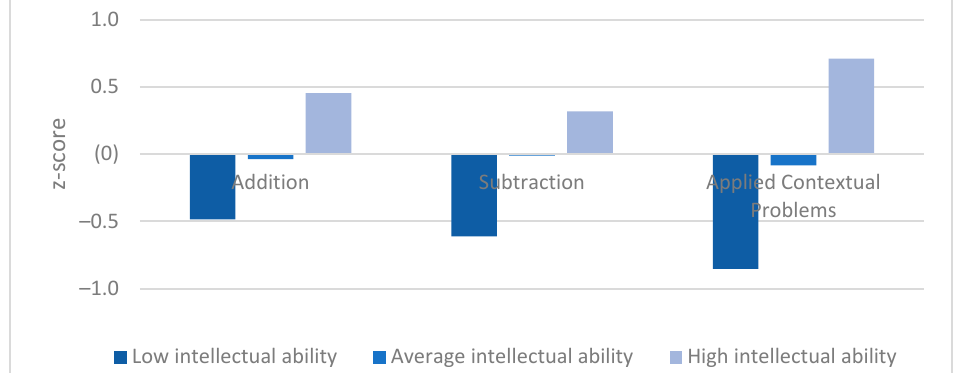
Figure 2. Comparison of achievements in mathematical tasks at t3 between low, average and high intellectual achievement groups. p ≤ 0.01 for all comparisons between groups.